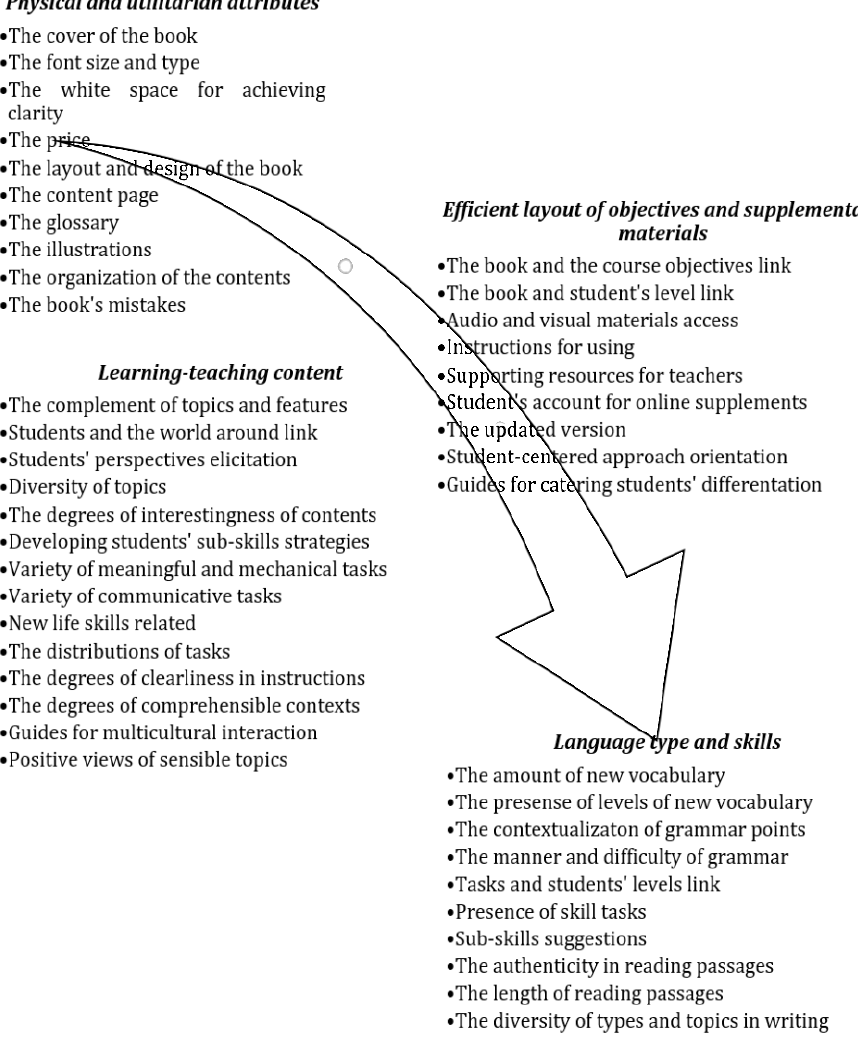
Figure 1. Checklist for evaluation on teaching reading and writing